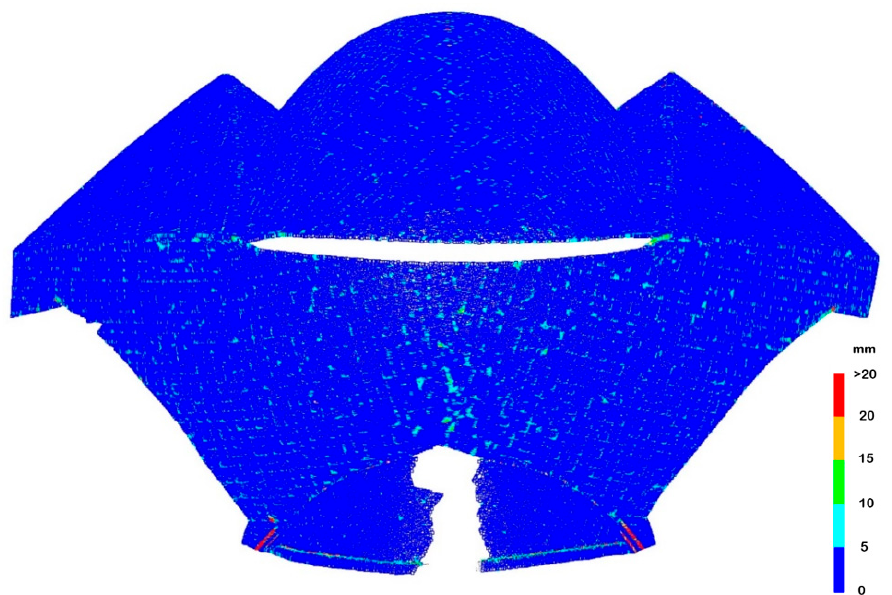
Figure 11. Deviations of point cloud from spline model for which patches separated by single edges were modelled separately.